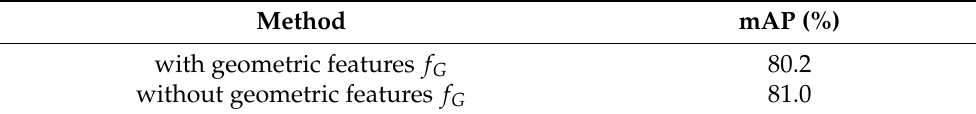
Table 6. Performance comparison with/without geometric features in object relation